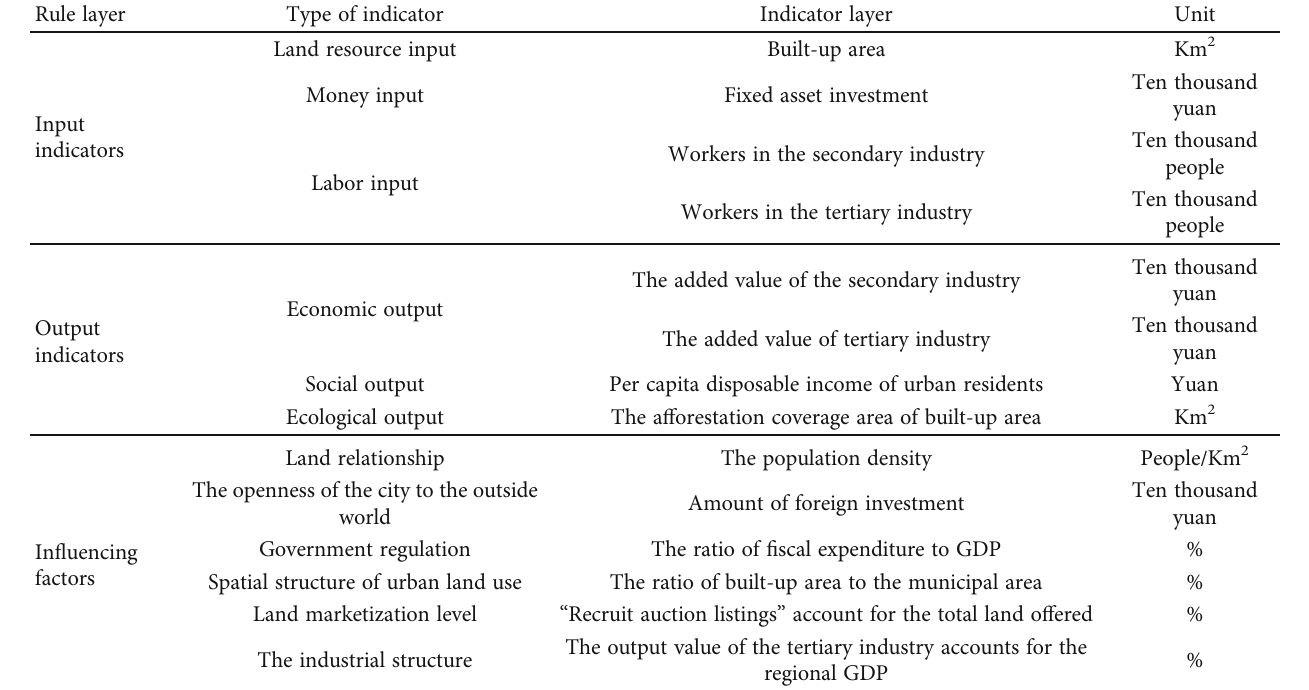
Table 3: Variable